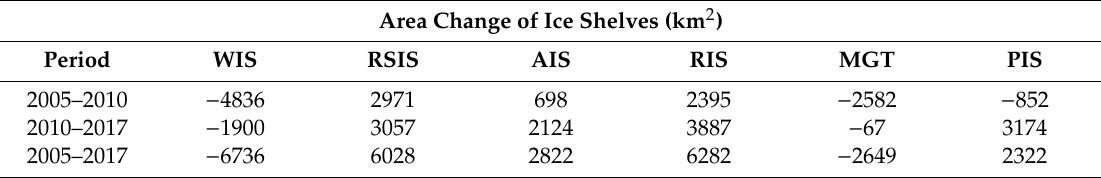
Table 7. Deviation of coastline area in each sector (km 2 ) during three